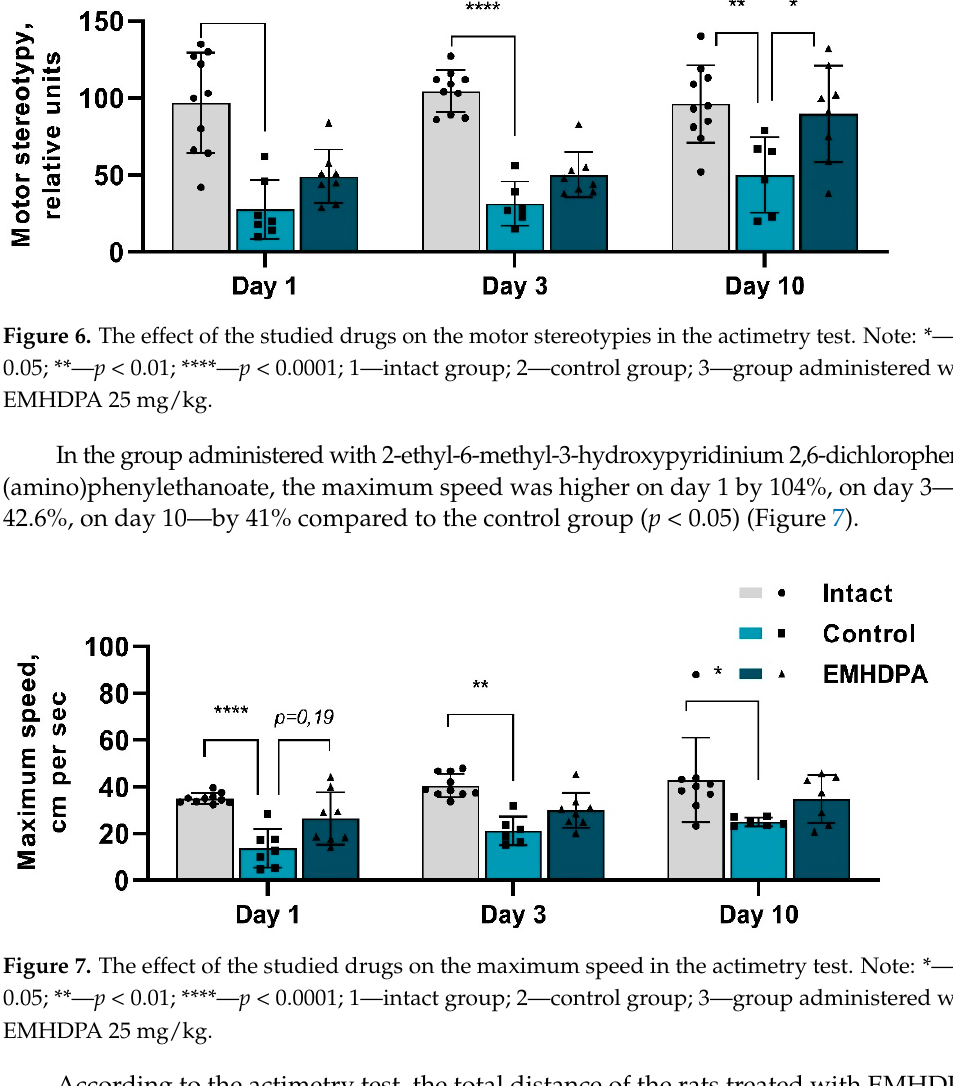
Figure 5. The effect of the studied drugs on the total activity in the actimetry test. Note: *— p < 0.05; ***— p < 0.001; ****— p < 0.0001; 1—intact group; 2—control group; 3—group administered with EMHDPA 25 mg/kg.